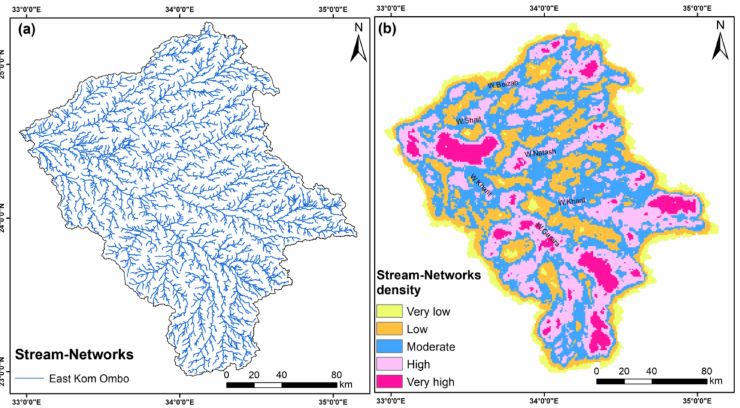
Figure 7. ( a ) Automatically derived stream-networks of the studied basins; ( b ) stream density map.